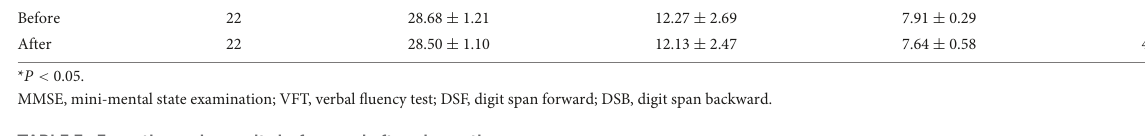
TABLE 3 Empathy scale results before and after chemotherapy.